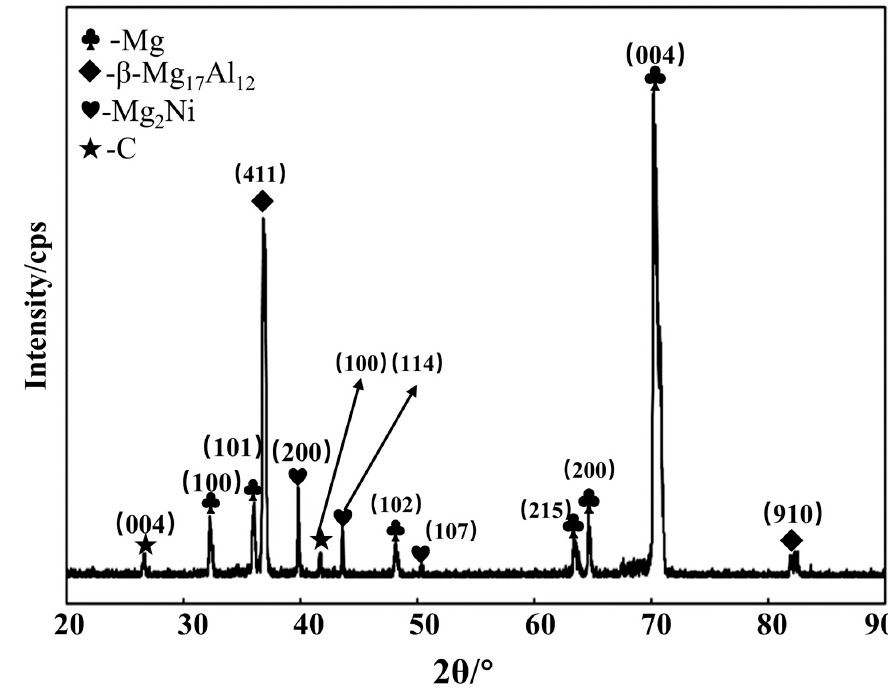
Figure 5. X-ray diffraction pattern of Ni-CNTs/AZ91 magnesium matrix